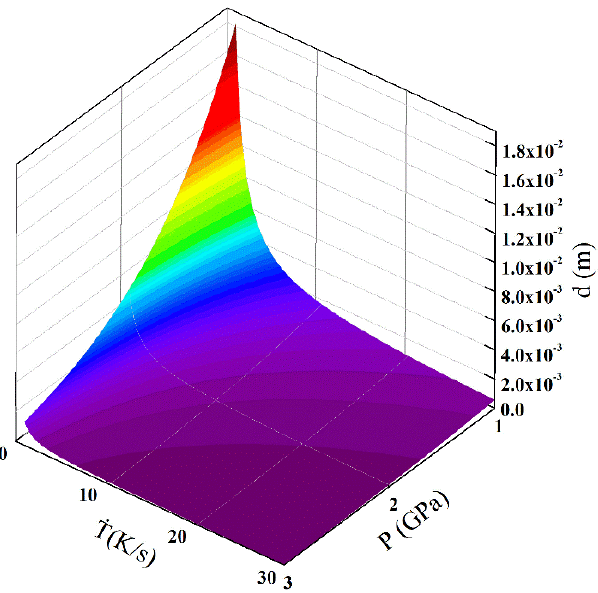
Figure 8. Effects of solidification pressure and cooling rate on the average grain size.